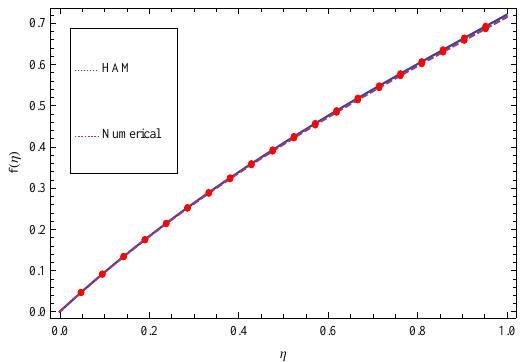
Figure 2. The comparison between HAM and numerical solutions for velocity profile f ( η ) , when h = − 0.25, λ = 0.9,kr = 0.9,Pr = 0.5,Ec = 0.5,Nb = 0.5,Nt = 0.6, β = 1 and Sc =